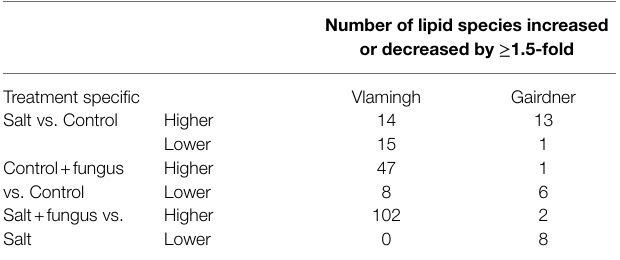
TABLE 4 | Number of significantly altered lipid species ( p < 0.05) with ≥ 1.5 fold- changes in relative abundance between the three treatment group comparisons for two barley